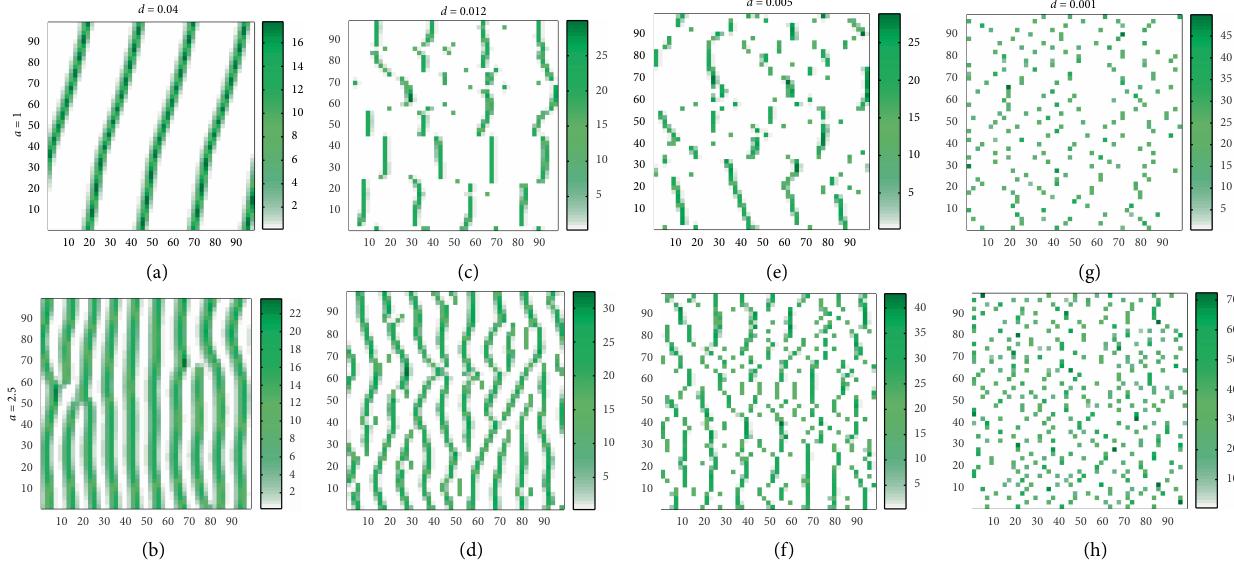
Figure 6: Irregular vegetation patterns self-organized on hillslopes as values of of IC2 can obtain similar results as well.